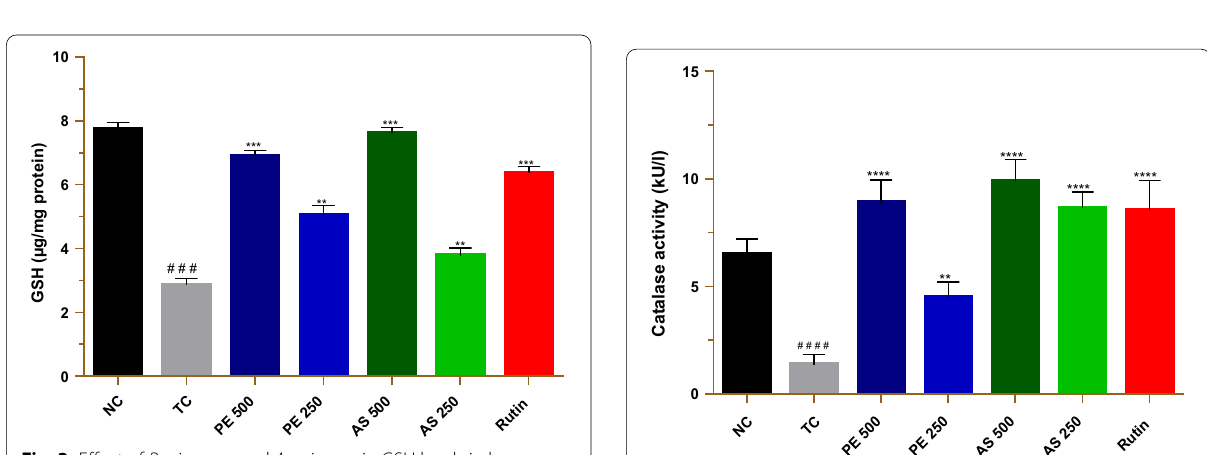
NC normal control; TC toxic control; MDA = = expressed as mean SEM. ## p < 0.01; ### p < 0.001; #### p < 0.0001; compared to NC; ** p < 0.01; *** p < 0.001; **** p < 0.0001; compared to TC. n ±